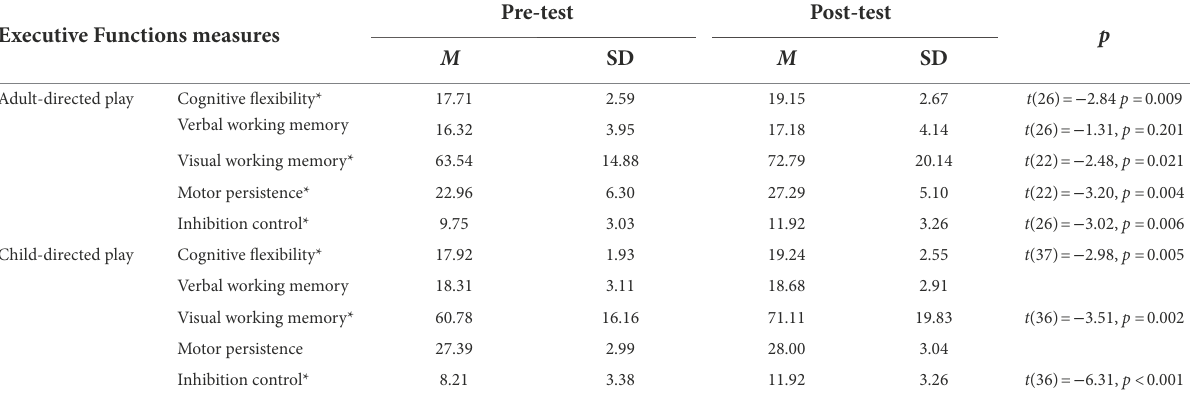
TABLE 1 Pre- and post-test differences in measures of executive functions within two experimental conditions of interest: “Child-directed play” and “Adult-directed play.”